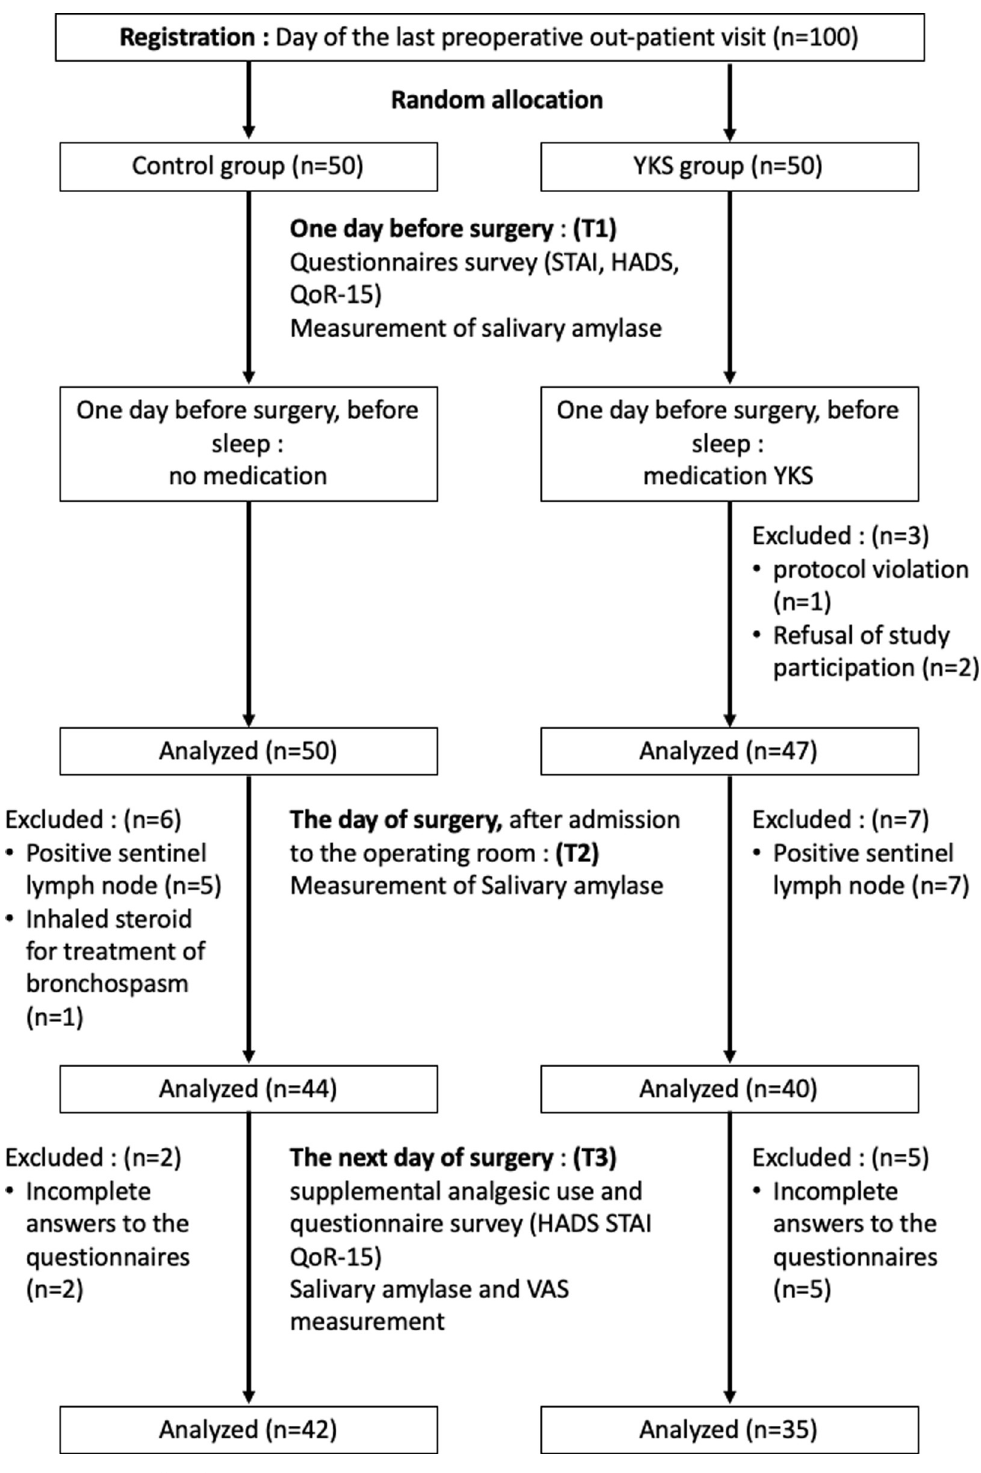
Fig 1. CONSORT flow